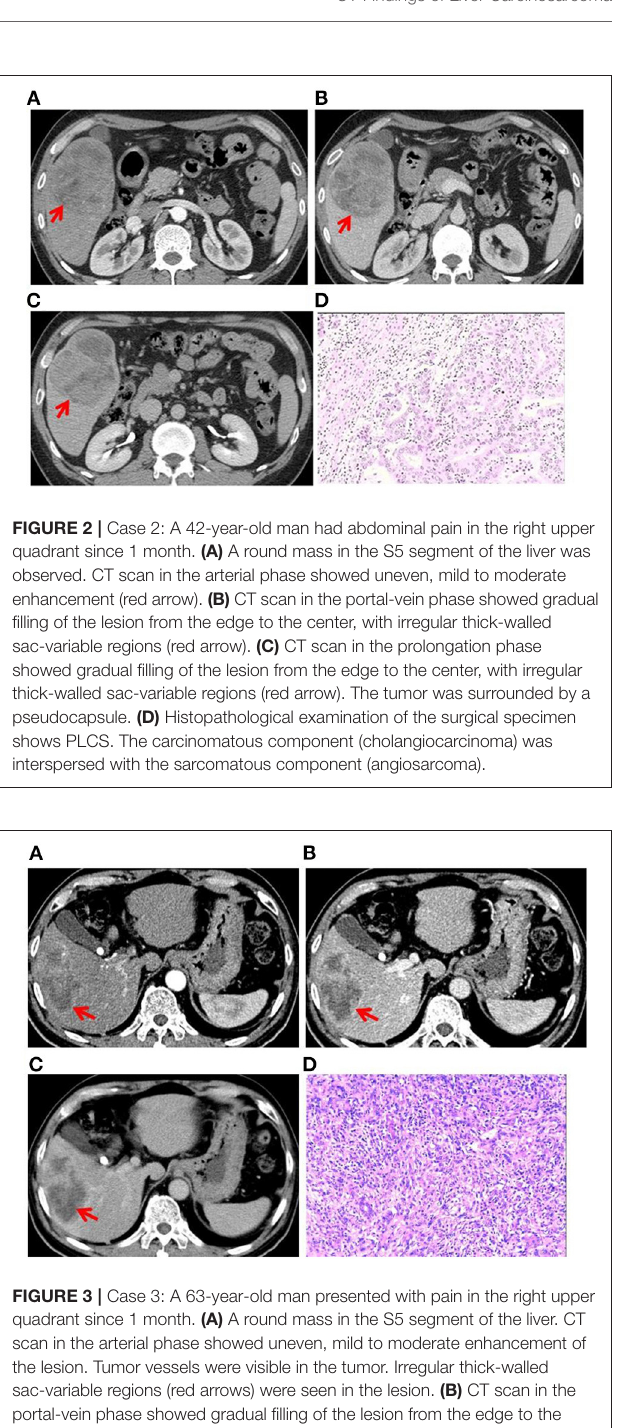
portal vein and established tumor thrombus were observed in case 1, in which one lesion broke through the hepatic liver capsule into adjacent tissues. Tumor recurrence and distant